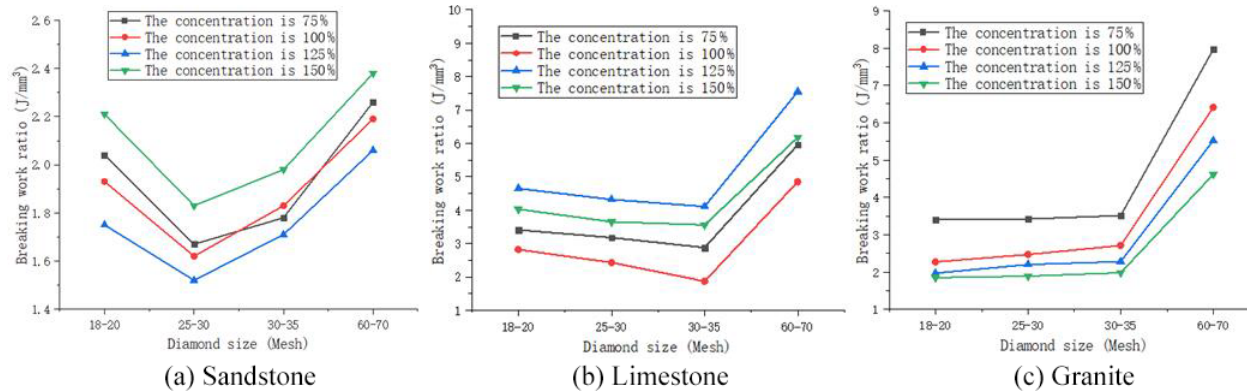
Figure 9. The breaking work ratio of different rock samples.